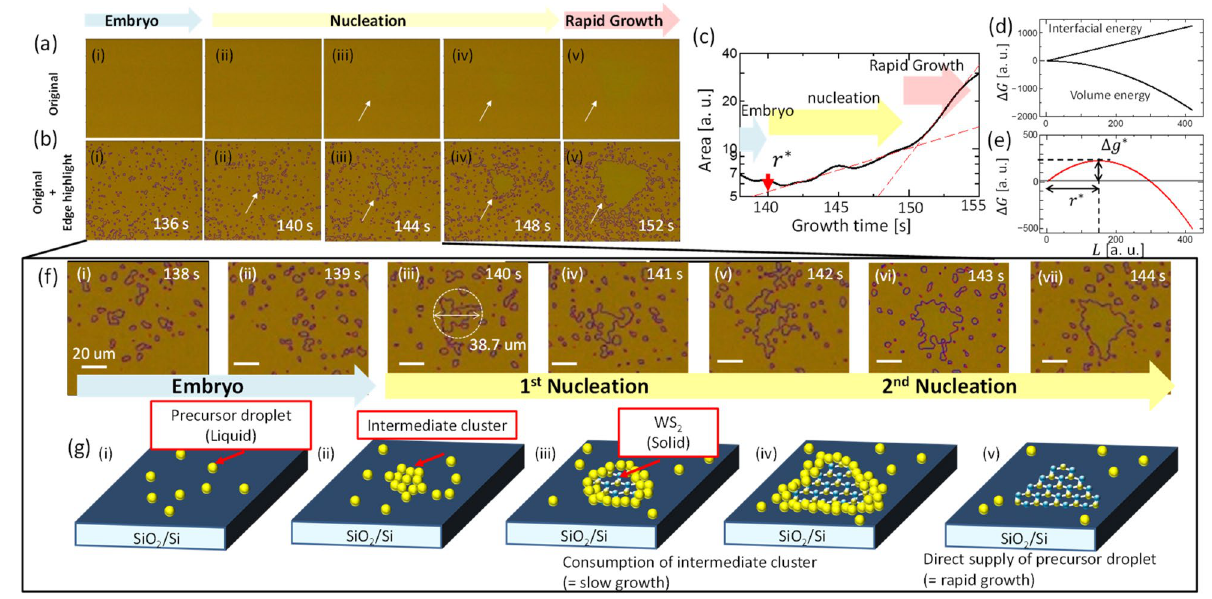
Figure 2. In-situ monitoring CVD. ( a , b ) Typical ( a ) original and ( b ) analyzed images of WS 2 growth obtained by in-situ monitoring CVD at different growth time (i: 136 s, ii: 140 s, iii: 144 s, iv: 148 s, v: 152 s). ( c ) Plot of monolayer area as a function of growth time. Two dashed lines show the different growth speed during the 1st–2nd nucleation and rapid growth period. ( d , e ) Calculated curves of ( d ) volume energy gain, interfacial energy loss, and ( e ) (cid:31) G as a function of L . ( f ) Time profile of analysed images between (i) 138 s and (vii) 144 s. ( g ) Schematic illustration of two-step nucleation of WS 2 (i: precursor supply, ii: 1st nucleation of intermediate cluster, iii: 2nd nucleation of WS 2 within intermediate cluster, iv: WS 2 growth within intermediate cluster, v: WS 2 growth during rapid